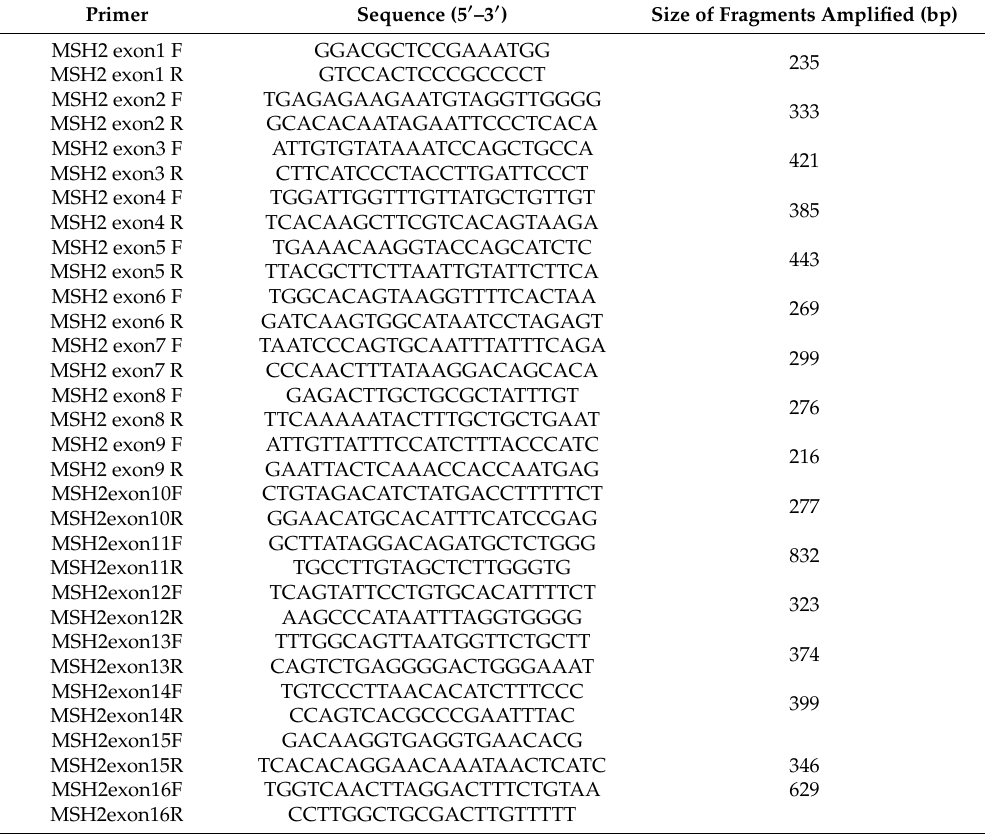
Table 3. Primers used to amplify exon of cMSH2